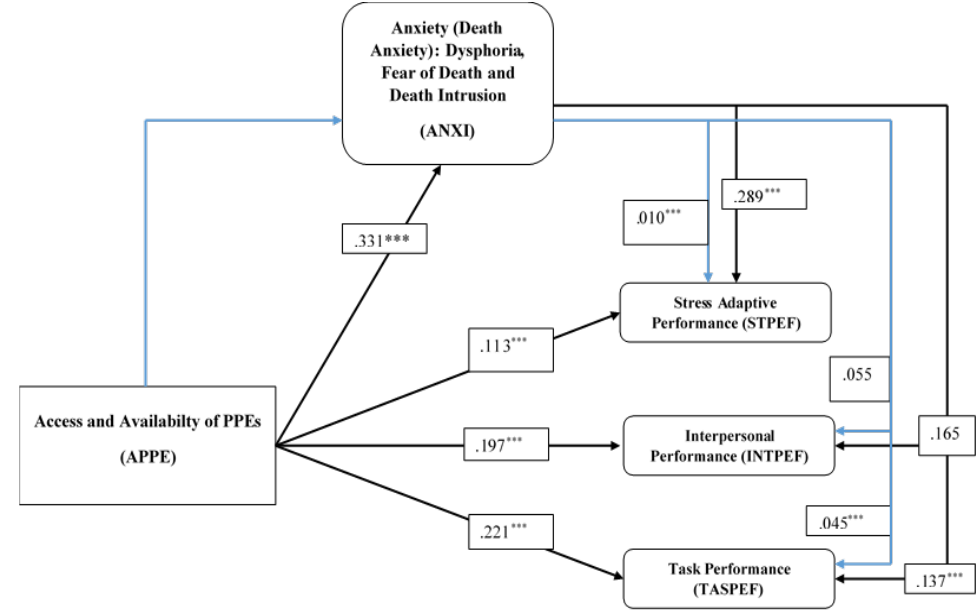
Figure 3. Path analysis. *** Significant at 95%, blue arrows signify mediation.